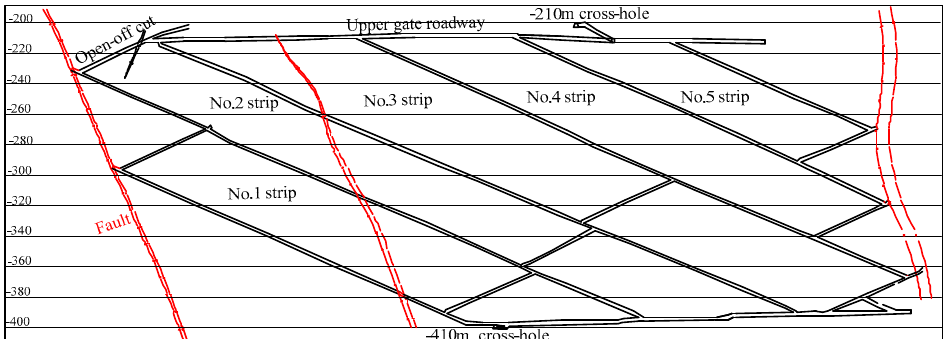
Figure 1. Roadway layout of the 845 working face.